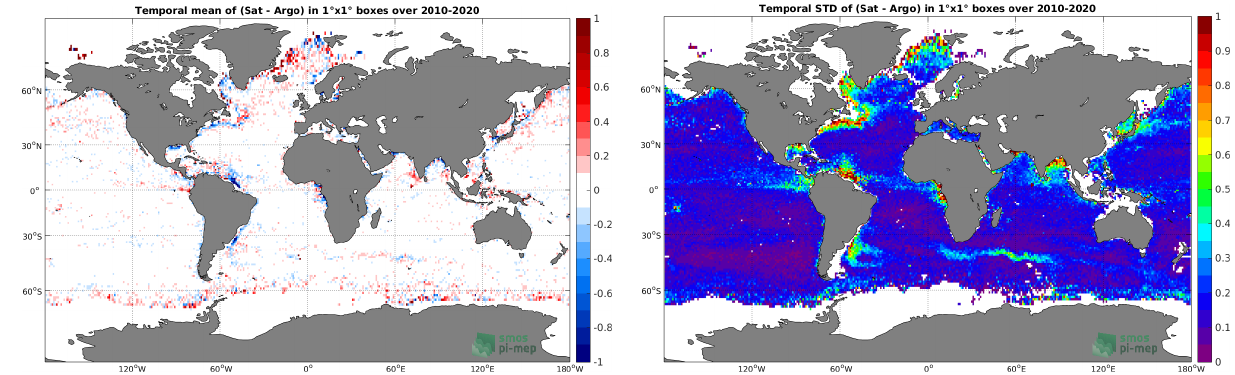
Figure 8. Temporal mean (left ) and STD ( right ) of SSS from CCI SSS L4 Merged-OI v3.2—30-day running (ESA) ( top ), Argo ( middle ), and of ∆ SSS (Satellite−Argo) ( bottom ). Only match-up pairs are used to generate these maps.